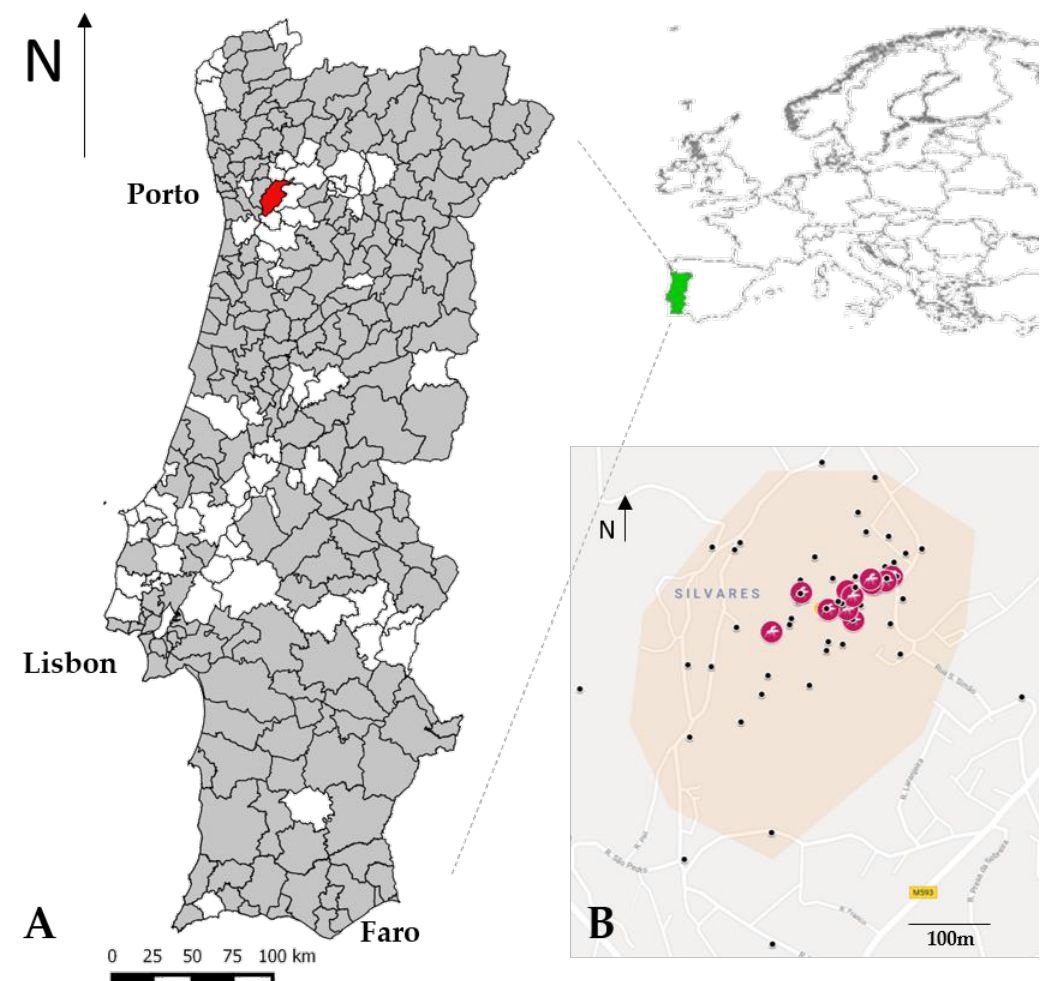
Figure 1. ( A ) In red, the positive location for Ae. albopictus in Portugal, municipality of Penafiel (LAU 1), parish of Guilhufe and Urrô (LAU 2) (41°11′08.1′′ N 8°19′45.7′′ W). In grey, the municipalities (LAU 1) surveyed under REVIVE in 2017; ( B ) Distribution map of traps and breeding sites (black points) in the premises of the tyre company and in the 200 m perimeter buffer around the company (rose area). The pink circles indicate the positive sites for the presence of Ae. albopictus .